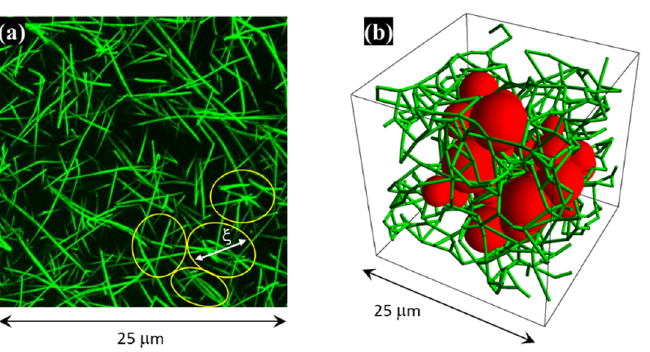
Figure 9. ( a ) Rendering of confocal optical microscope images taken on an aged fibrin gel. The yellow ellipses indicate regions of higher fiber density; ( b ) 3D representation of an (in-silico) fibrin gel, where in red are shown the spheres with the largest diameters that can be optimally fit (tangent to the fibers) in the pore zones of the gel. Their average diameter corresponds to the gel pore size. Pictures adapted with permission from Refs. [41,42].